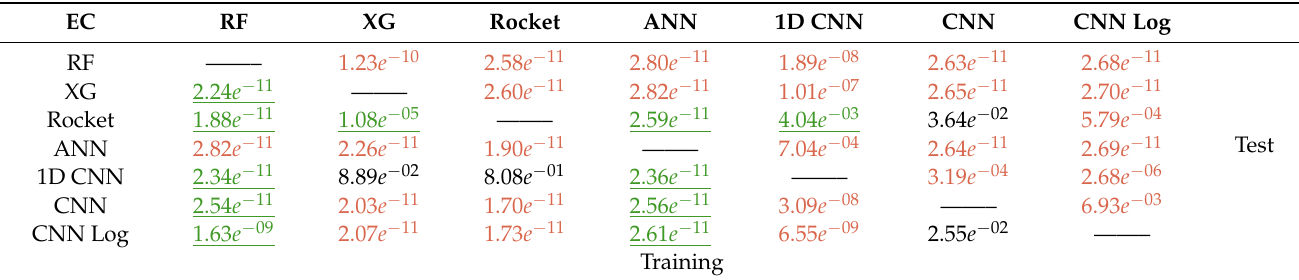
Table A1. Kruskal–Wallis p -values comparing all methods of the EC prediction task. Above the diagonal, we have the results for the test set, and below for the training set. Significant results ( p < 0.01) are represented in green or red when the method on the left is significantly better or worse, respectively.